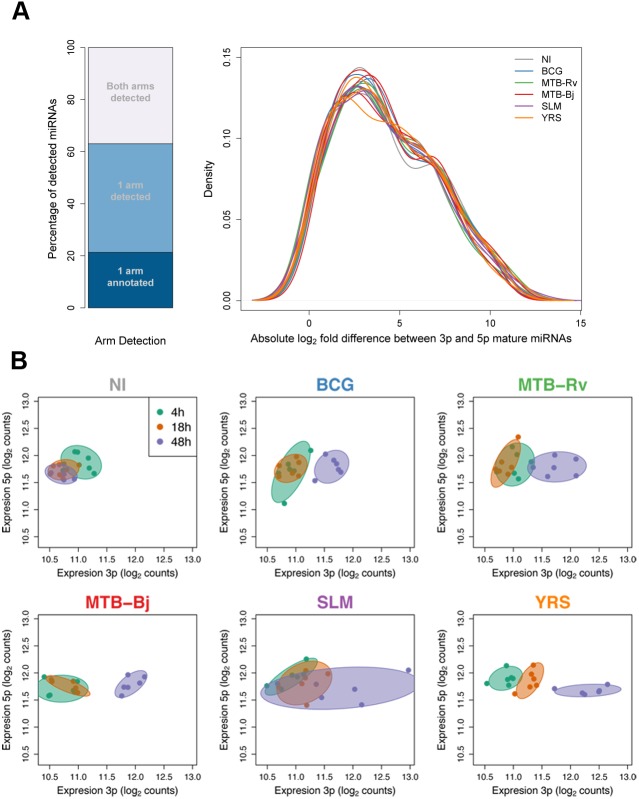
Changes in relative miRNA arm expression upon infection.(A) Detection and relative expression of miRNA hairpin arms. Stacked bar plot shows the proportion of detected miRNA hairpins for which either one or both mature miRNA sequences were detected. Density plot shows the distribution of log2 expression ratios for hairpins where both arms were expressed. (B) An example of one miRNA, miR-361, which showed a strong infection-dependent change in relative arm expression. Axes show the expression of the 3p and 5p arms of all sequenced individuals at each time point. In each panel, colours denote the different time points, and infection conditions are plotted in separate panels. The displacement of points towards the right of the plot in infected samples at later time points shows that the change in the expression ratio of the two arms is due to the increased expression of the 3p arm that, in some conditions, becomes dominant.